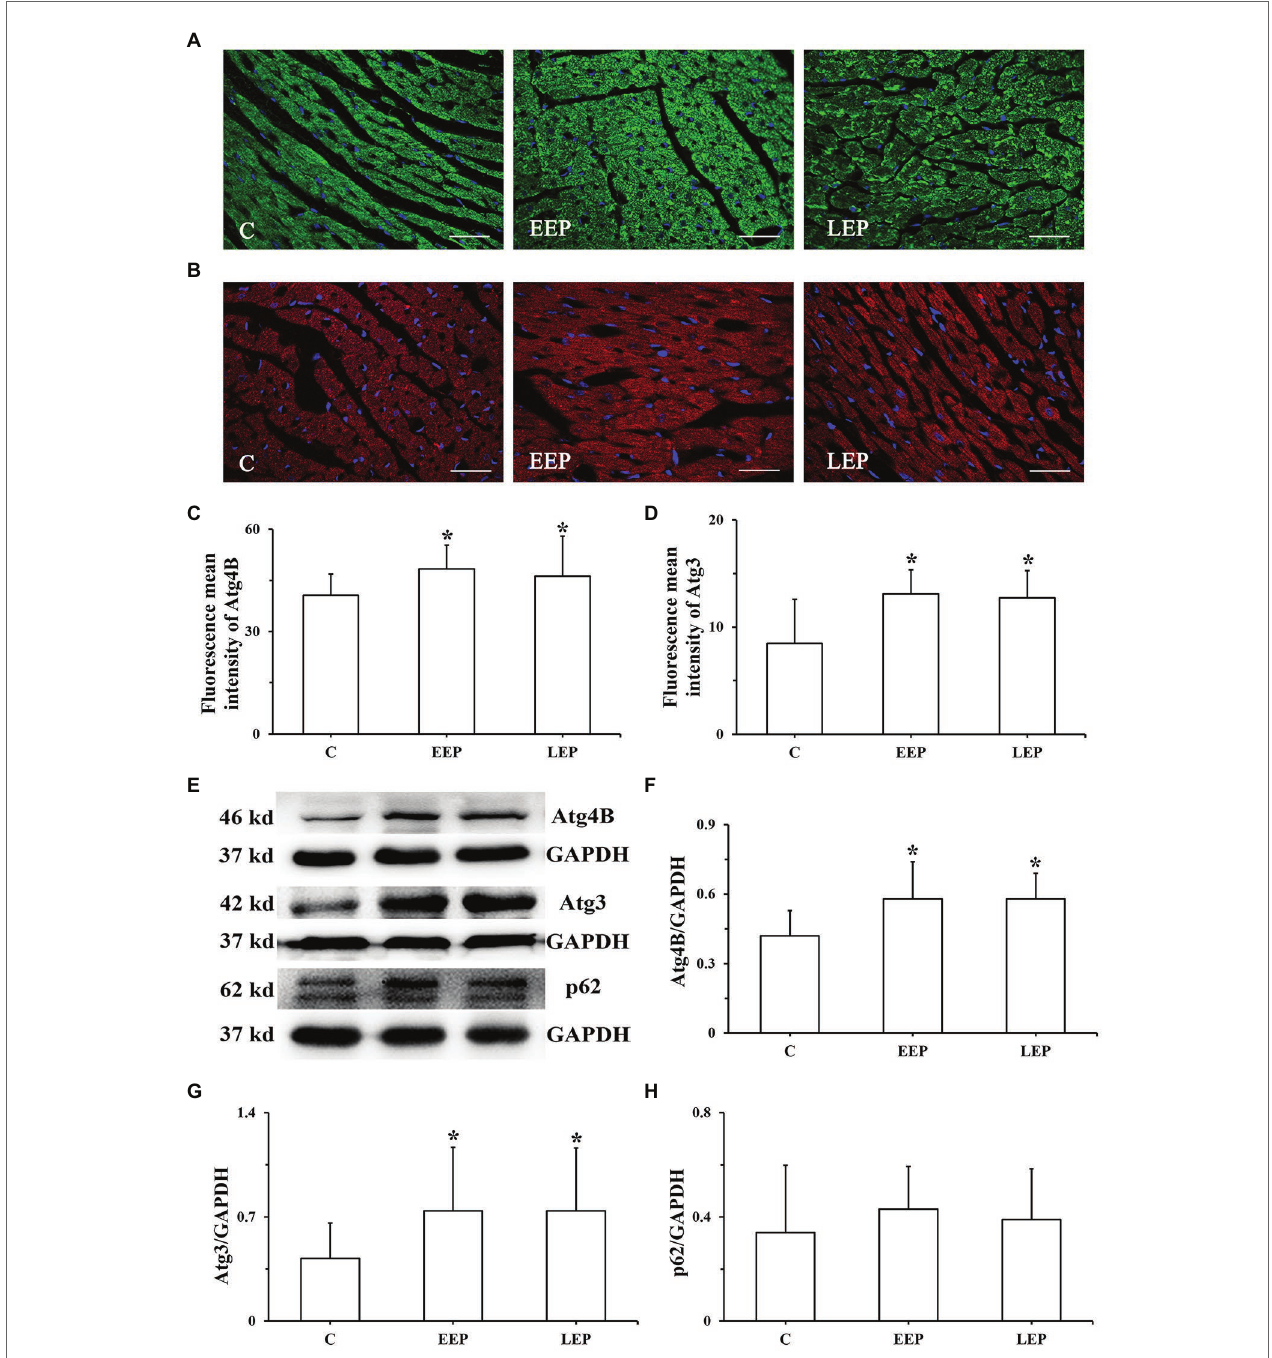
FIGURE 5 | Expression of Atg4B, Atg3, and p62 levels during EP. (A) Immunofluorescence staining of Atg4B in cardiomyocytes (bar = 100 μ m). Atg4B was stained green and had a scattered distribution in group C. (B) Immunofluorescence staining of Atg3 in cardiomyocytes (bar = 100 μ m). Atg3 was stained red and had a scattered distribution in group C. (C) Fluorescence mean intensity of Atg4B immunofluorescent staining. (D) Fluorescence mean intensity of Atg3 immunofluorescent staining. (E) : Western blot of Atg4B, Atg3, and p62. (F) Western blot analysis of Atg4B in different groups. (G) Western blot analysis of Atg3 in different groups. (H) Western blot analysis of p62 in different groups. * p < 0.05 vs. group